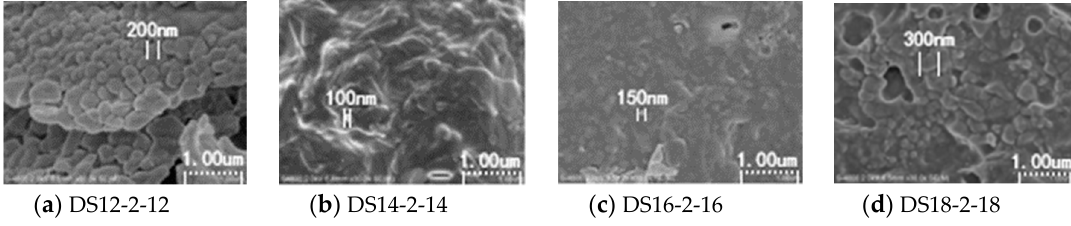
Figure 2. Effect of hydrophobic chain on micelle structure of DSm-2-m solution.